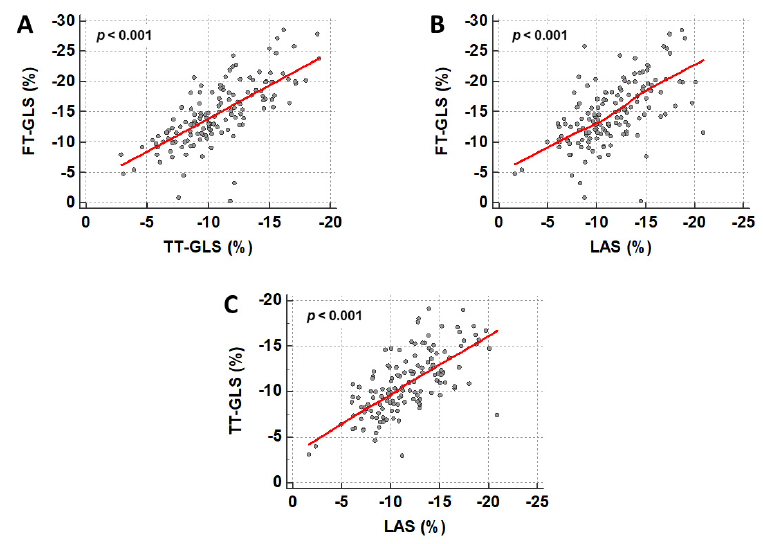
Figure 3. Correlation between different CMR-based approaches for strain assessment. Scatter plots show a significant correlation between FT-GLS and TT-GLS ( A ), FT-GLS and LAS ( B ), and TT-GLS and LAS ( C ). FT = feature tracking; GLS = global longitudinal strain; LAS = long-axis strain; TT = tissue tracking.